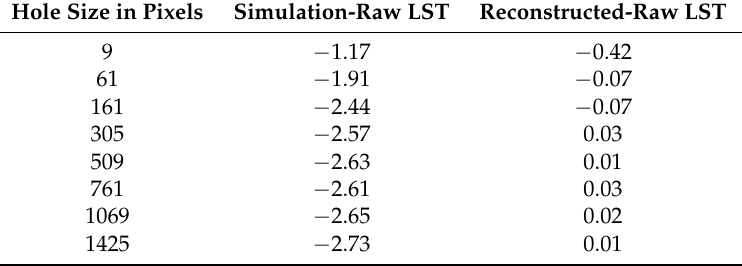
Table 1. Difference of the reconstruction over simulated gaps with the raw data in K. For reference, the difference of the reconstructed land surface temperature (LST) values without simulation (only outlier filtering) to the raw data is also